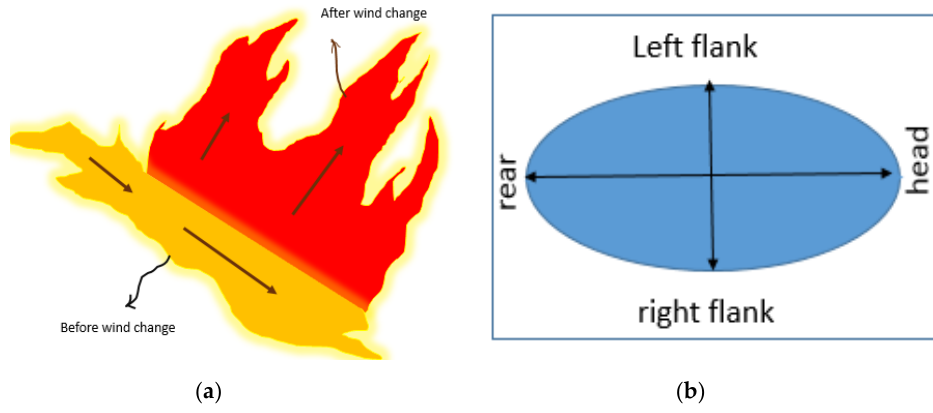
Figure 4. ( a ) A flank fire produced by alteration in the direction of wind. ( b ) Different sides of the fire in terms of head, rear and